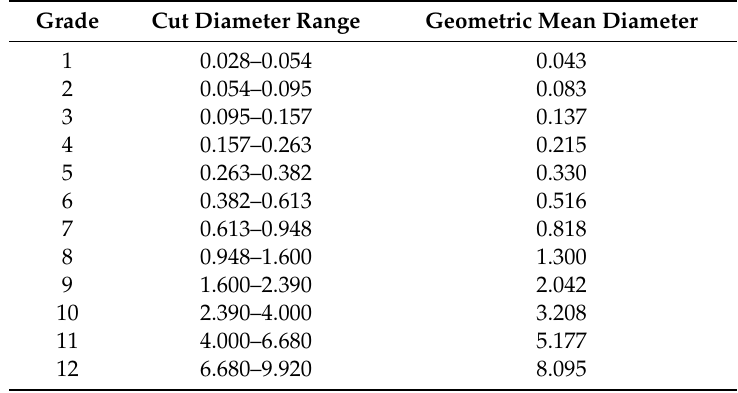
Table 2. Particle size ranges of twelve grades of particulate matter (PM) collected by ELPI ( µ m). Grade